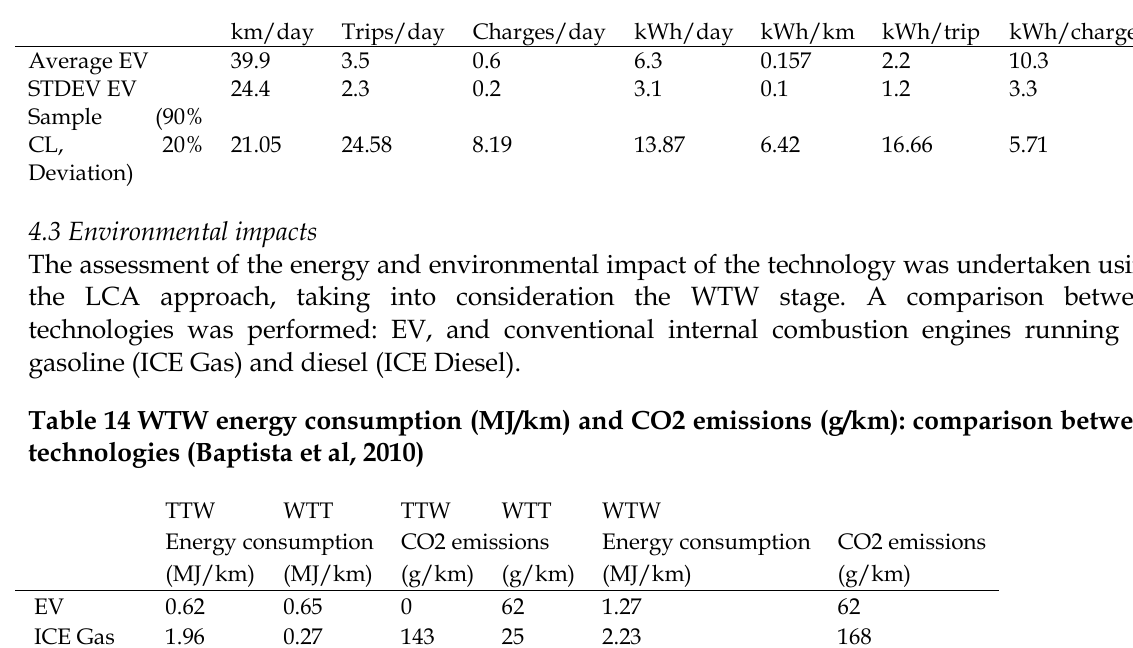
Table 13 Users’ electric mobility profile, deviation and level of confidence